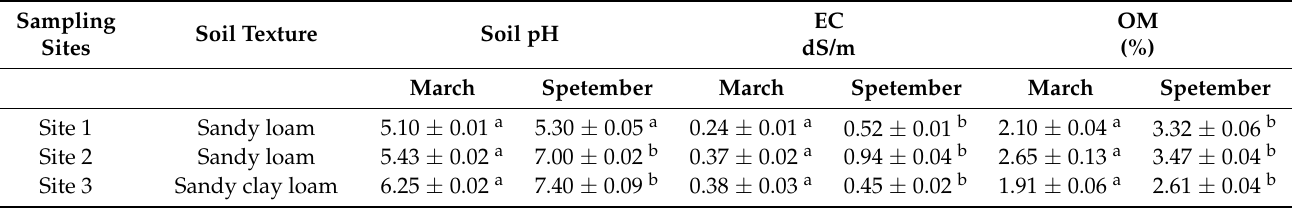
Table 3. Chemical properties of soil in each sampling site collected in March and